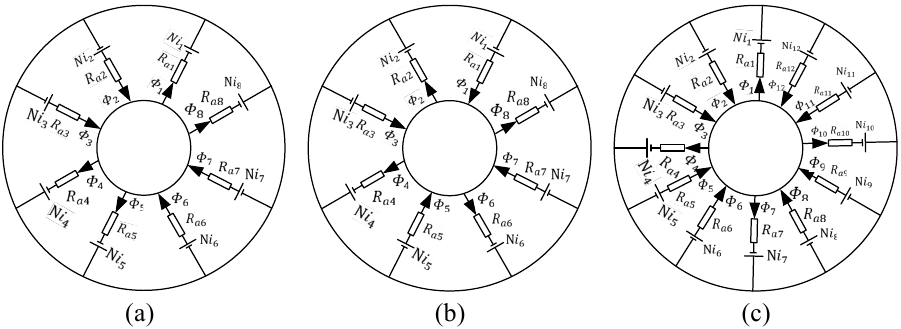
Figure 8. The 8 ‐ pole RMB equivalent magnetic circuits. ( a ) The magnetic circuit of NNSS magnetic pole distribution. ( b ) The magnetic circuit of NSNS magnetic pole distribution. ( c ) The magnetic circuit of 12 pole E ‐ type structure distribution.